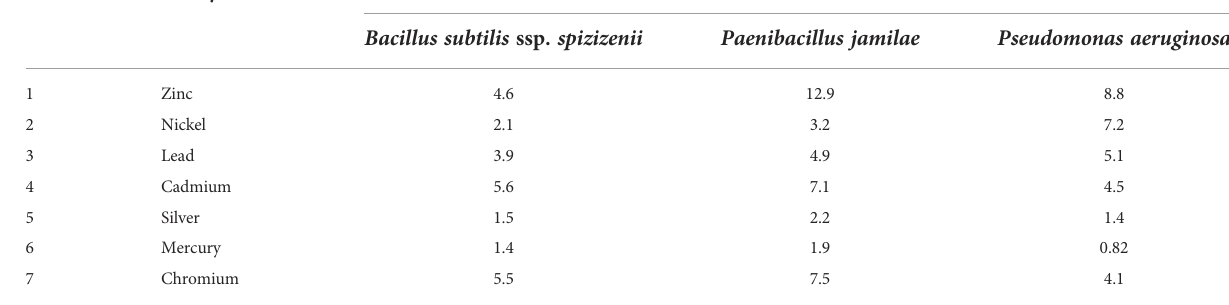
TABLE 2 Minimum inhibitory concentration (MIC) of heavy metal for soil bacterial isolates. S.